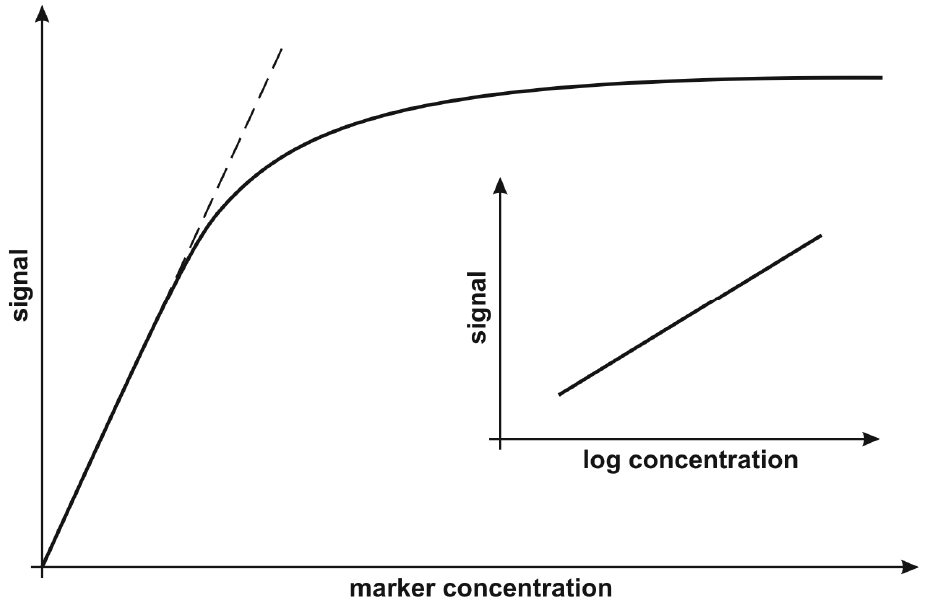
Figure 7. Typical calibration curves.